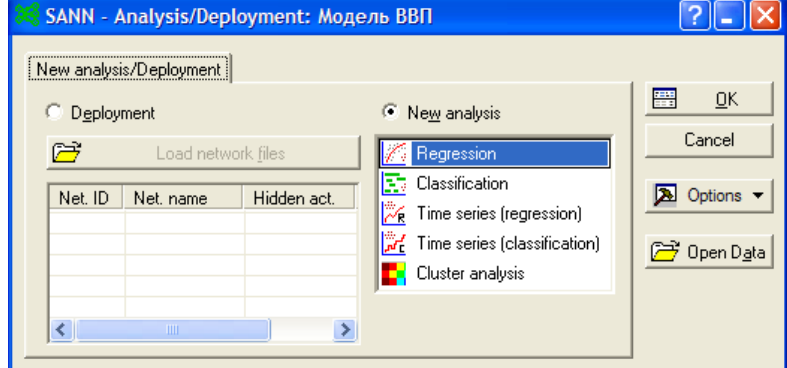
Fig. 1. The initial selection window of the mode of data